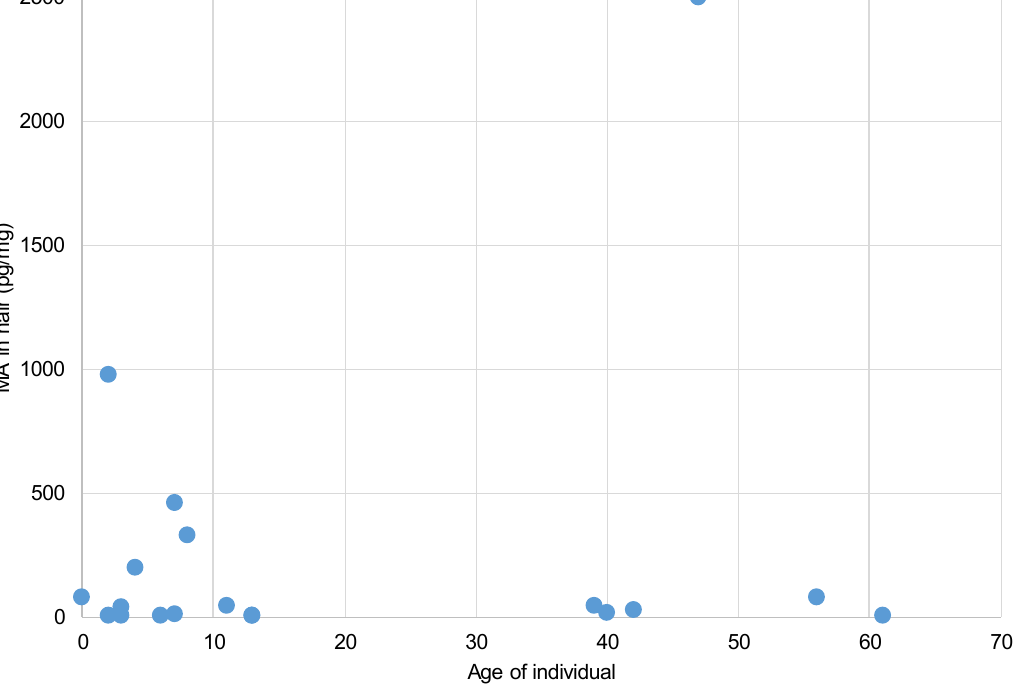
Figure 3. Methamphetamine levels (pg/mg) detected in hair by age for all participants exposed to environmental methamphetamine residues in case studies.